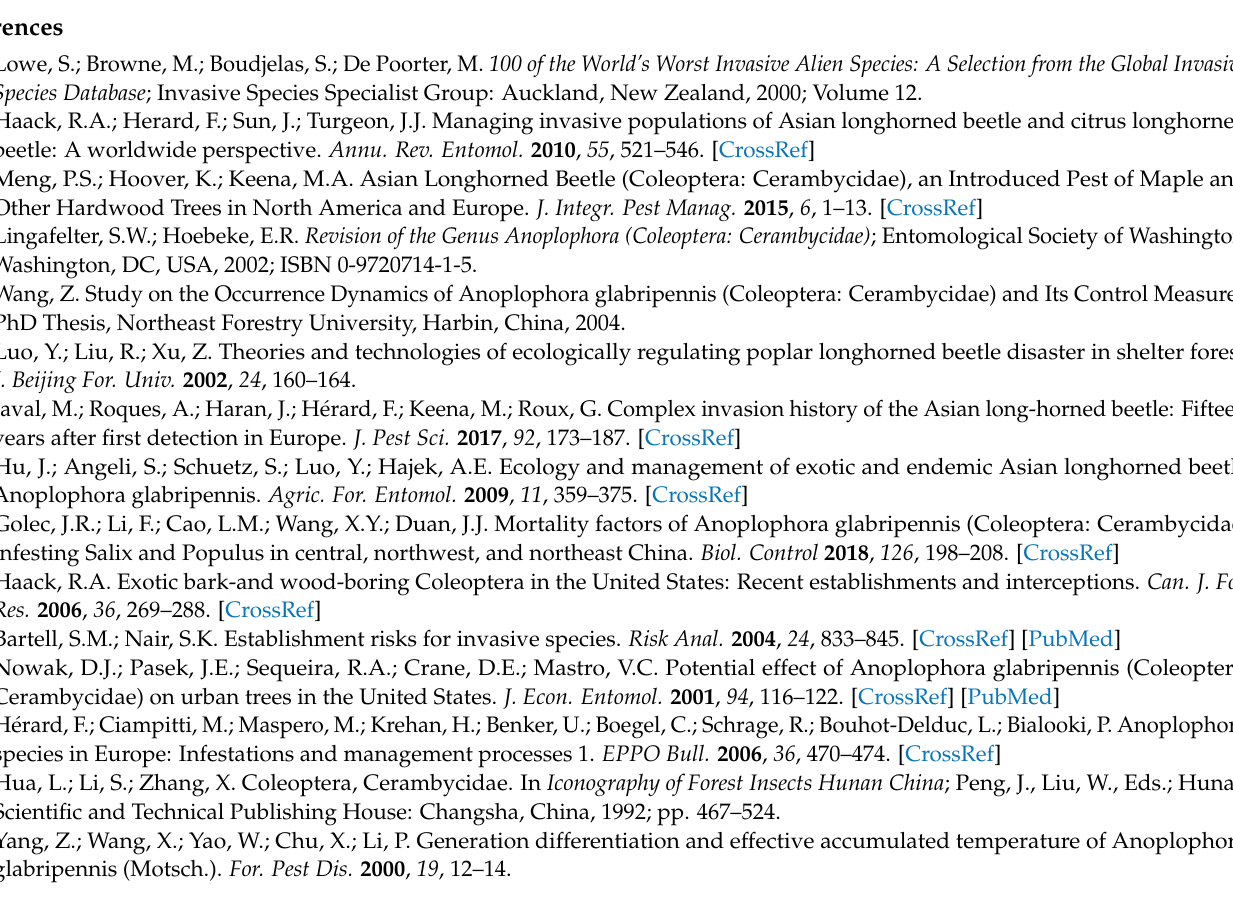
Figure A1. The population data of ALBs in each landscape from L1-L11(landscape 1 – landscape 11). y (the average number of emergence holes and frass holes in each landscape).